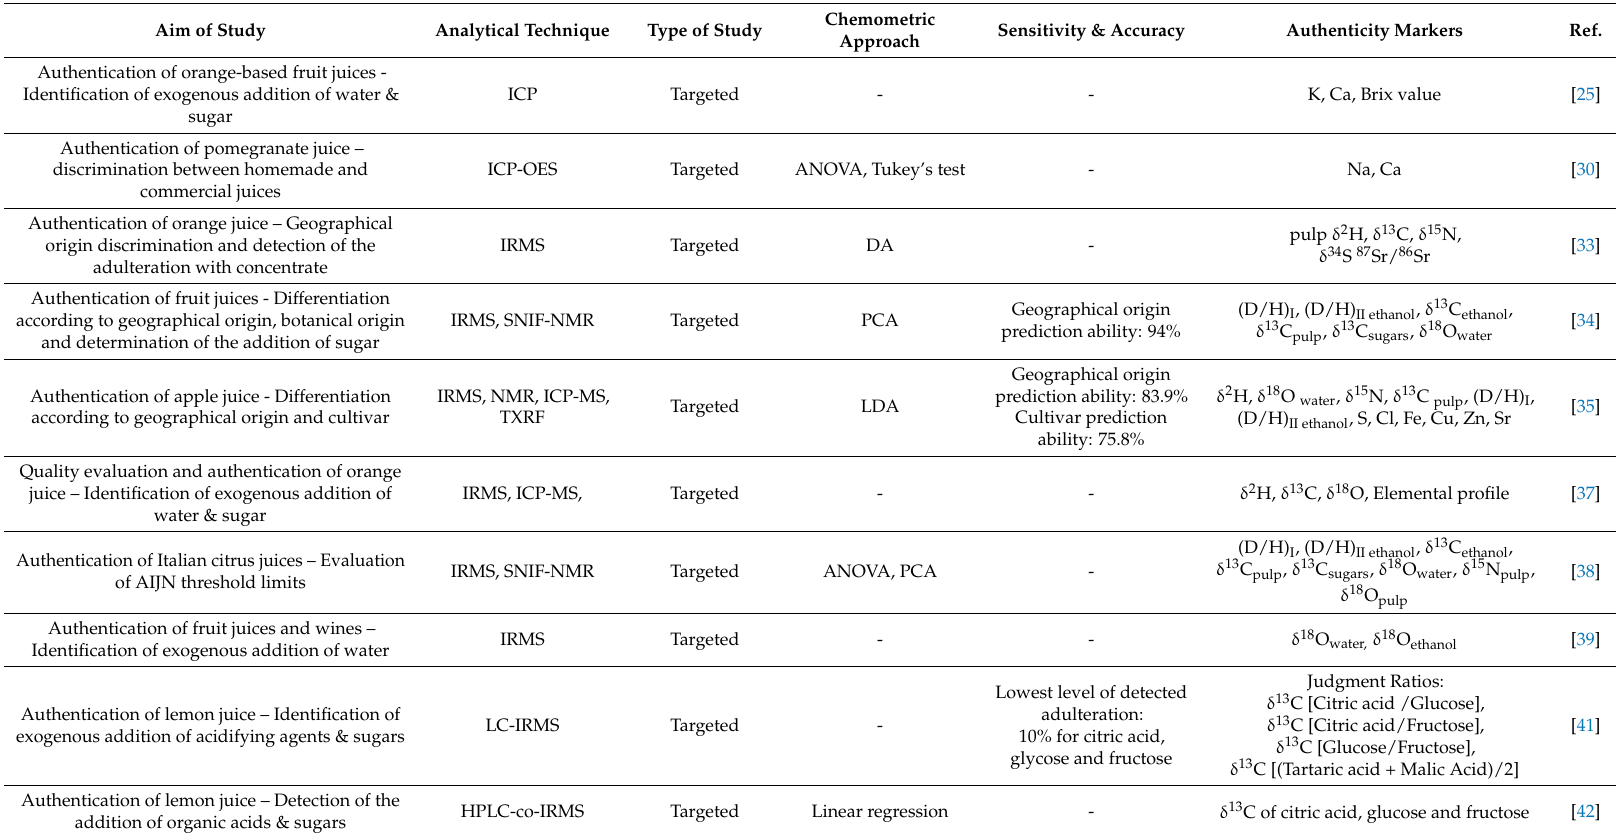
Table 2. Applications of isotope and elemental techniques in authenticity studies of fruit